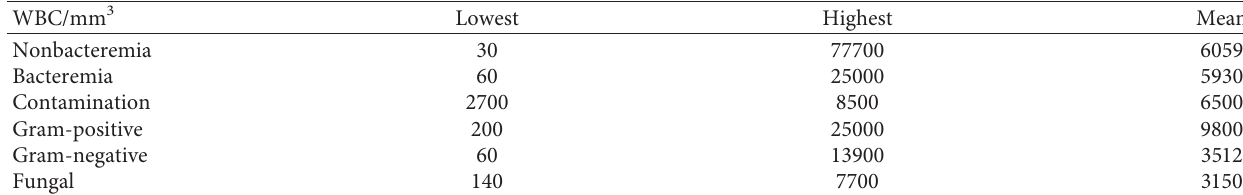
Table 1: Lowest and highest WBC averages across groups.